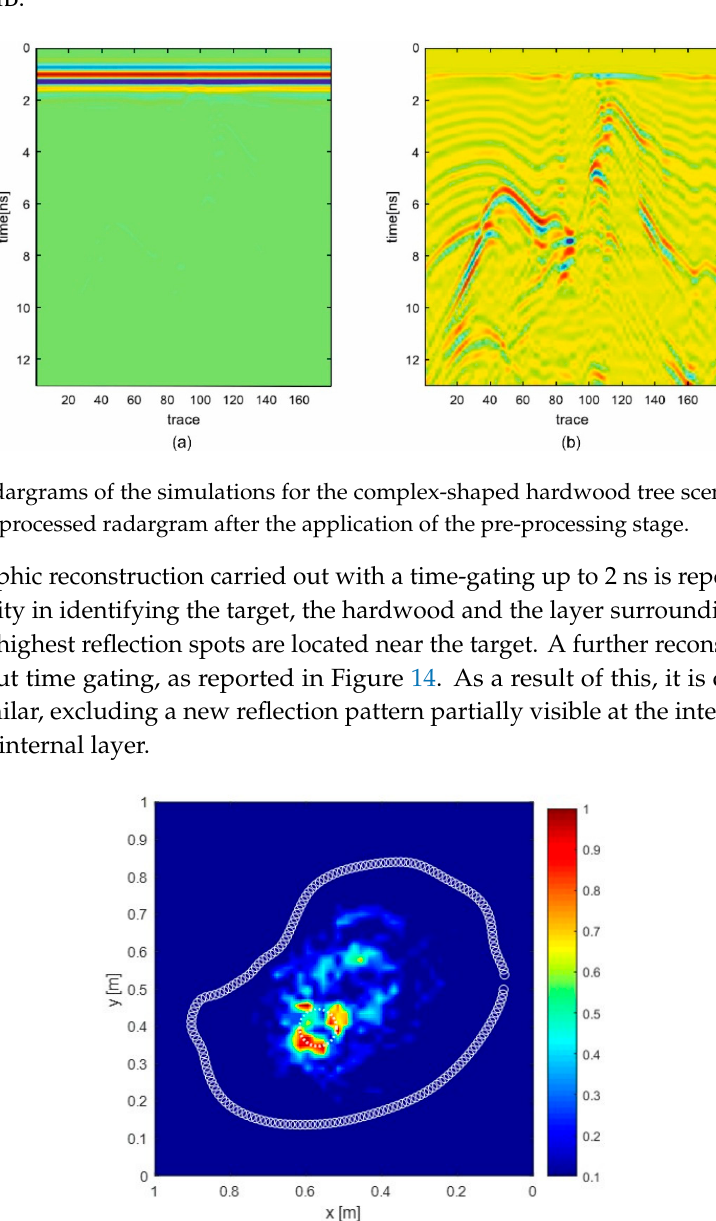
Figure 13. Tomographic reconstruction of the complex-shaped hardwood tree scenario with time-gating up to 2 ns. The dashed white circle indicates the actual position of the anomaly. The circles in white solid line along the trunk perimeter represent the positions of the measurement points.